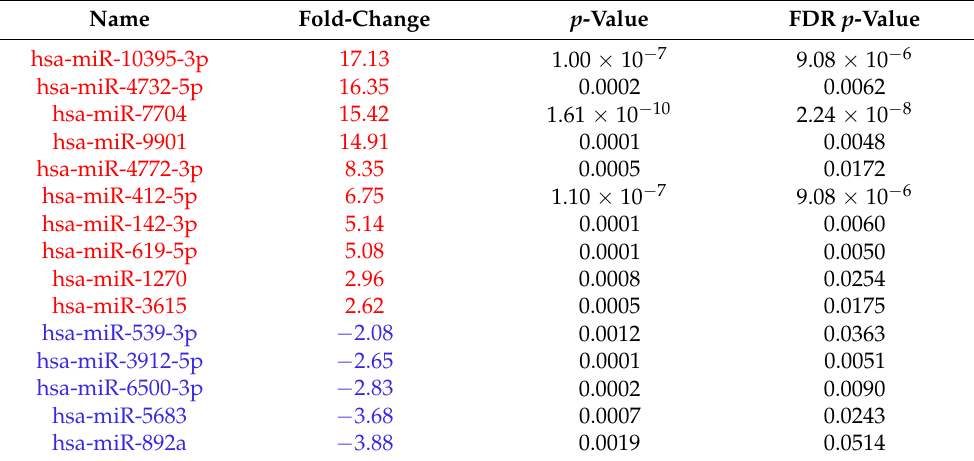
Table 2. Differential (>2-fold change, FDR < 0.05) expression of newly detected miRNAs in human stroke brain tissue. Red—upregulated, blue—downregulated